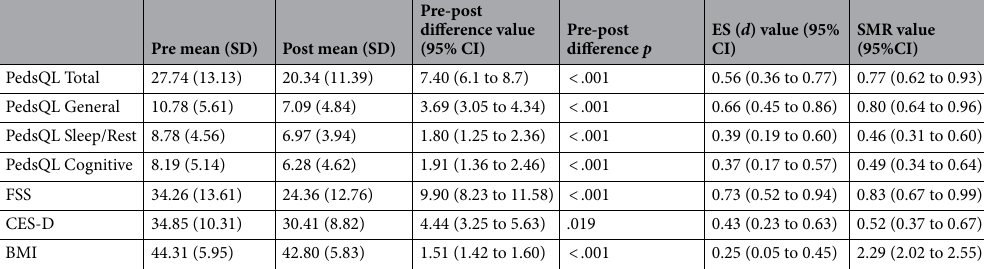
Table 2. Internal Responsiveness and pre-post changes of patient reported outcomes (n =